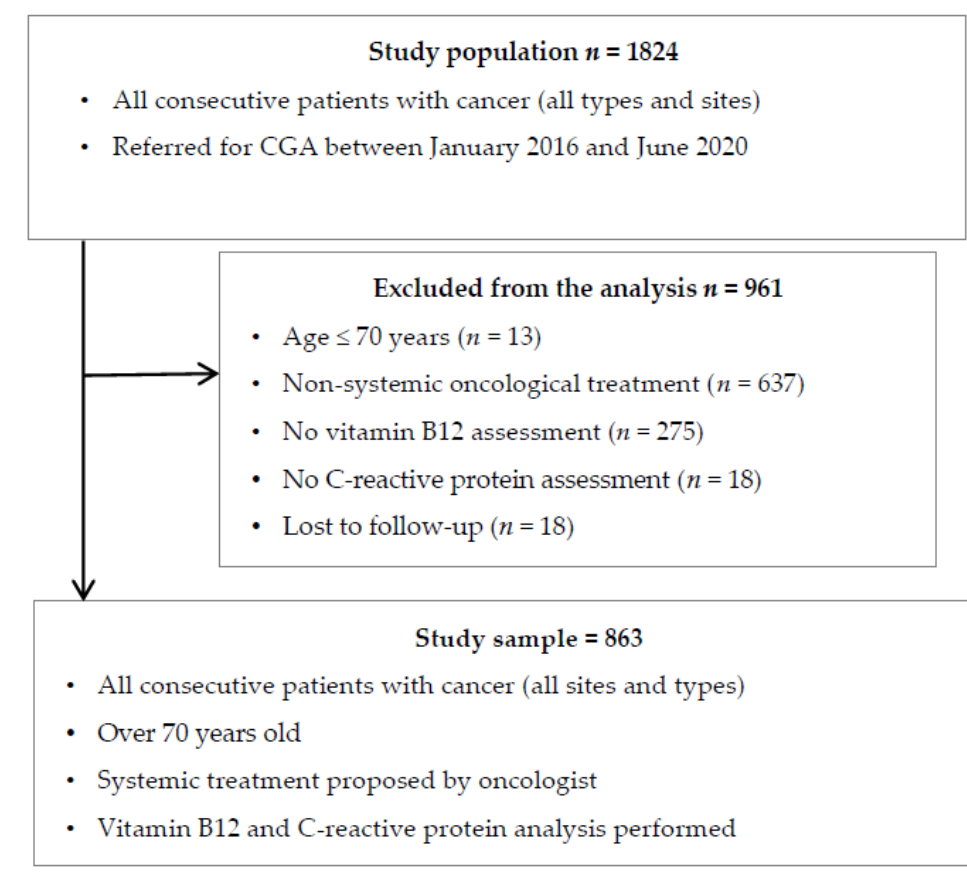
Figure 1. Flow Figure 1. Flow chart.